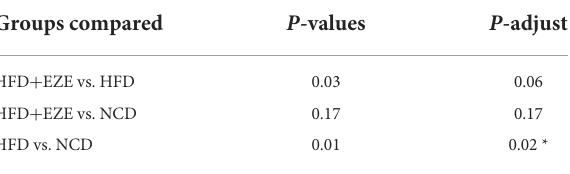
TABLE 2 PERMANOVA analysis of gut microbiota based on weighted Unifrac distance. Groups compared P -values P -adjust